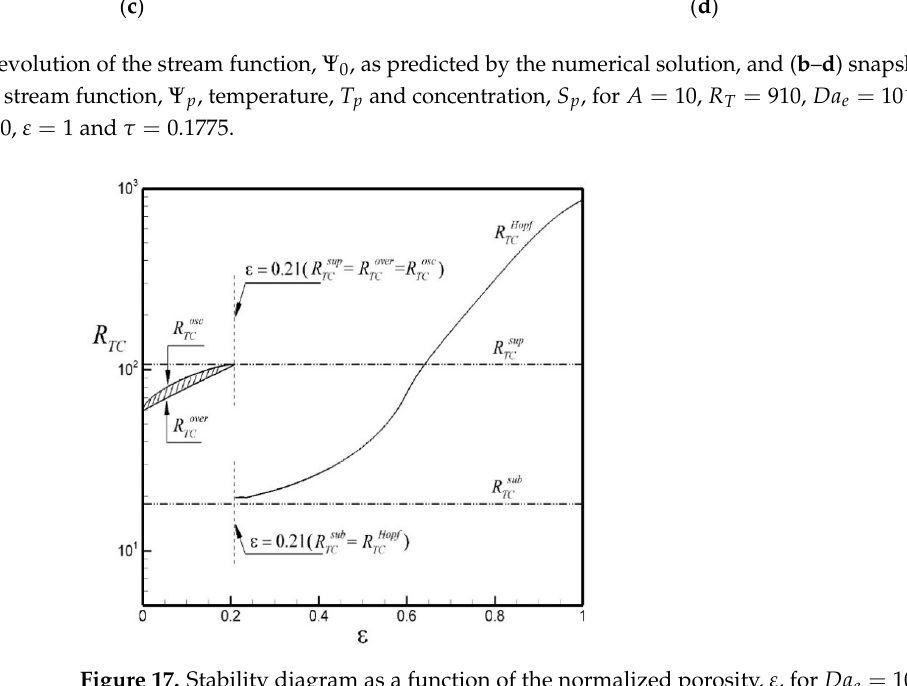
Figure 17. Stability diagram as a function of the normalized porosity, ε , for Da e = 10 − 4 , Le = 2 and D u = S r =